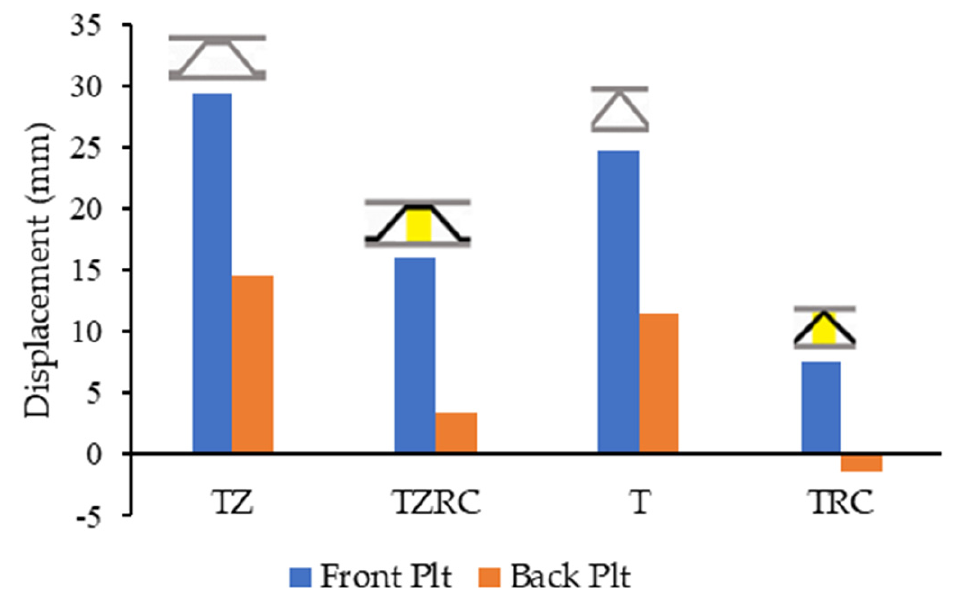
Figure 9. Residual midspan deflections for the facing sheets of sandwich structures with different core configurations under the impact of detonation of 55 g TNT at SoD 100 mm.